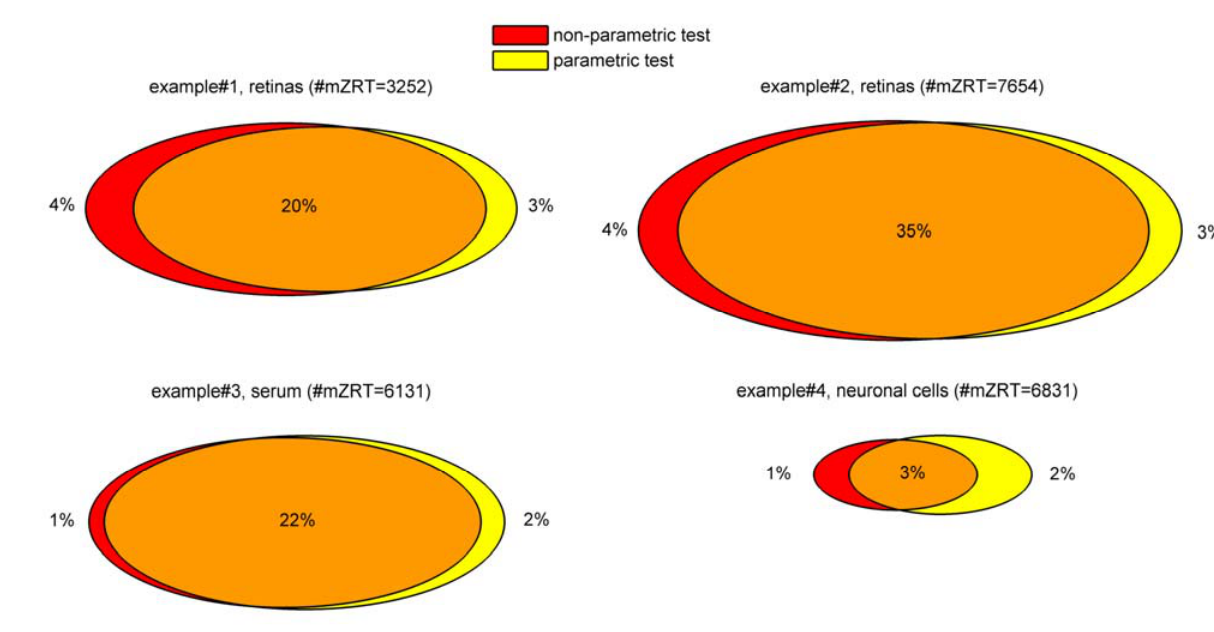
Figure 3. Venn-Diagrams of the mzRT features showing statistical significance using either parametric or non-parametric tests. Venn-Diagrams’ areas are proportional to the percentage of the significantly varied features out of the number of total features retained after handling analytical variation (indicated in parenthesis) .The Mann-Whitney test (examples #1, 2 and 4) or Wilcoxon signed rank (example #3) tests were used for non-parametric groups median comparisons. Unpaired (examples #1, 2 and 4) or paired (example #3) t-tests were used for parametric groups mean